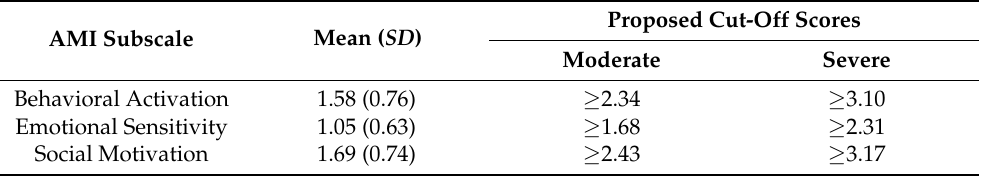
Table A2. Mean ratings, standard deviations and proposed cut-off scores of the AMI subscales (behavioral activation, social motivation and emotional sensitivity) based on the data of 479 healthy individuals as published by Ang et al.